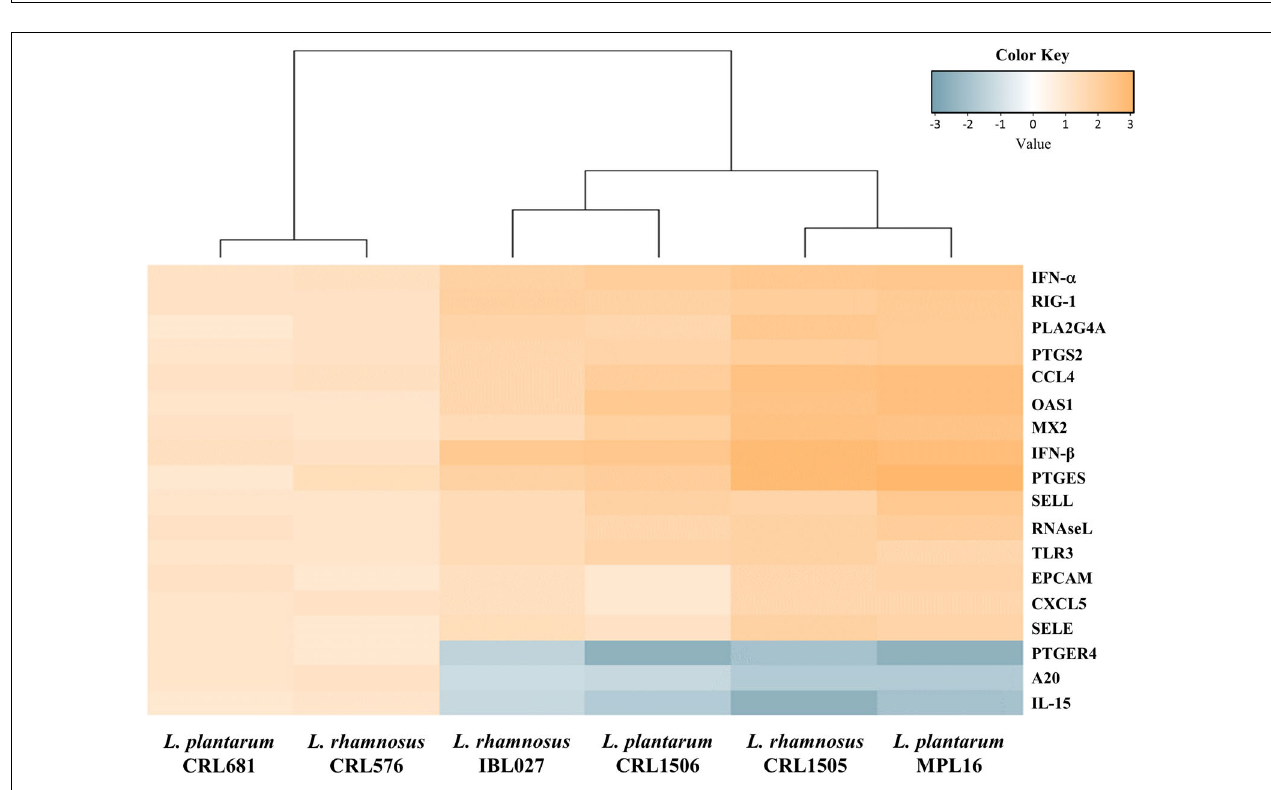
FIGURE 3 | Heat map analysis of the differentially regulated genes in porcine intestinal epithelial (PIE) cells treated with Lactobacillus rhamnosus CRL1505, L. rhamnosus IBL027, L. rhamnosus CRL576, Lactobacillus plantarum CRL1506, L. plantarum MPL16, or L. plantarum CRL681 and challenged with the viral molecular–associated pattern